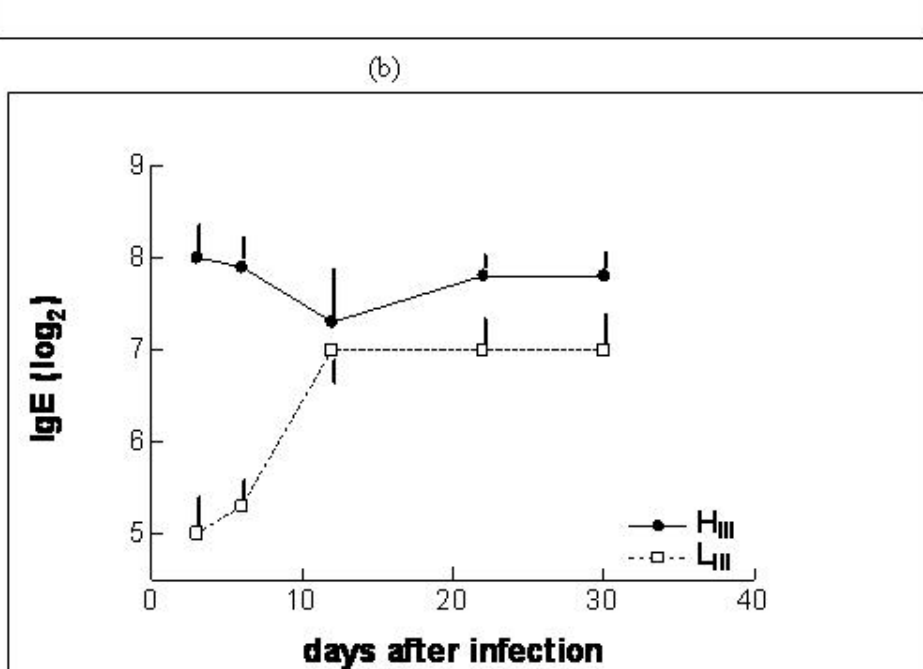
Figure 2. Kinetics of IgG2a (a) and IgE (b) synthesis in H during PV rabies virus strain infection. Animals were intramuscularly infected with 0.1 ml of PV rabies virus (titer of 10 4.9 LD 22 and 30 and the isotype profile of antibodies were determined by